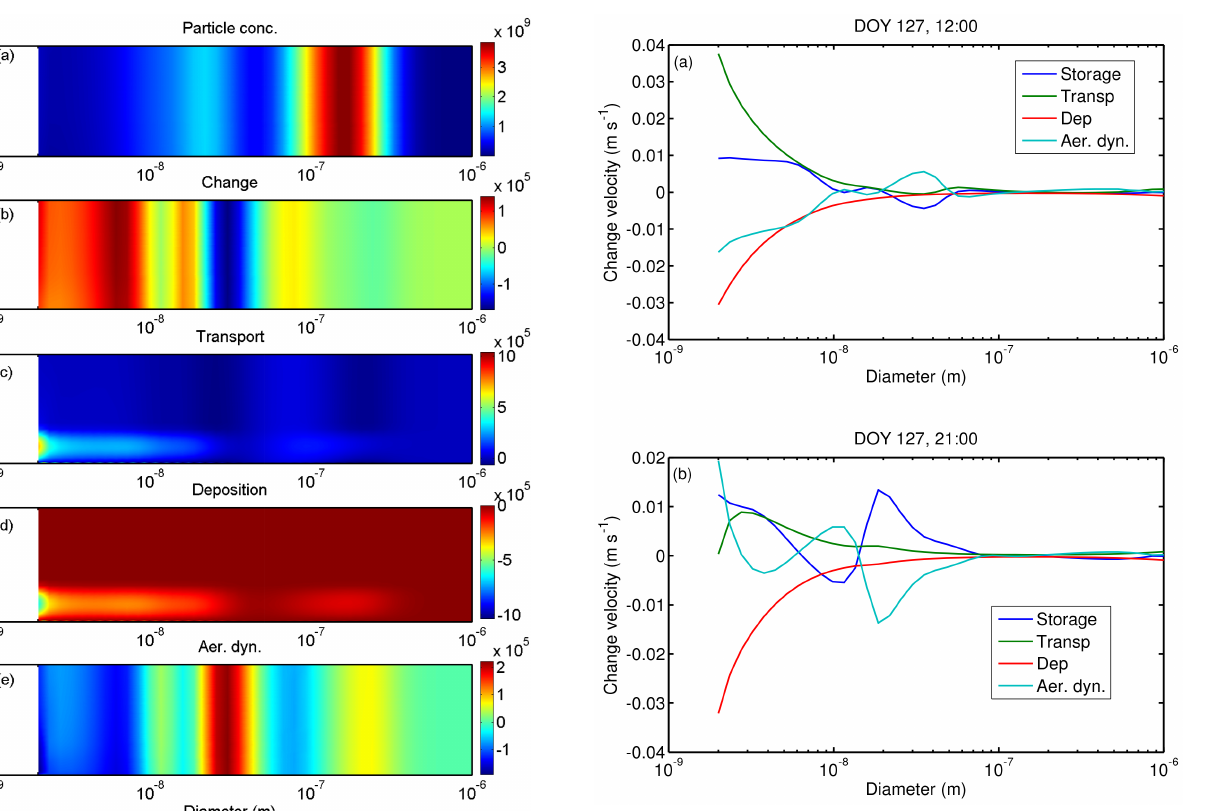
Figure 4. Vertical profiles of aerosol (a) number concentration (particlesm − 3 ) and conservation terms: (b) storage change (par- ticlesm − 3 s − 1 ) , (c) transport (in particlesm − 3 s − 1 ) , (d) deposi- tion (in particlesm − 3 s − 1 ) and (e) aerosol dynamical (in parti- clesm − 3 s − 1 ) on 7 May at 12:00LT for particle size range from 2nm to 1µm.